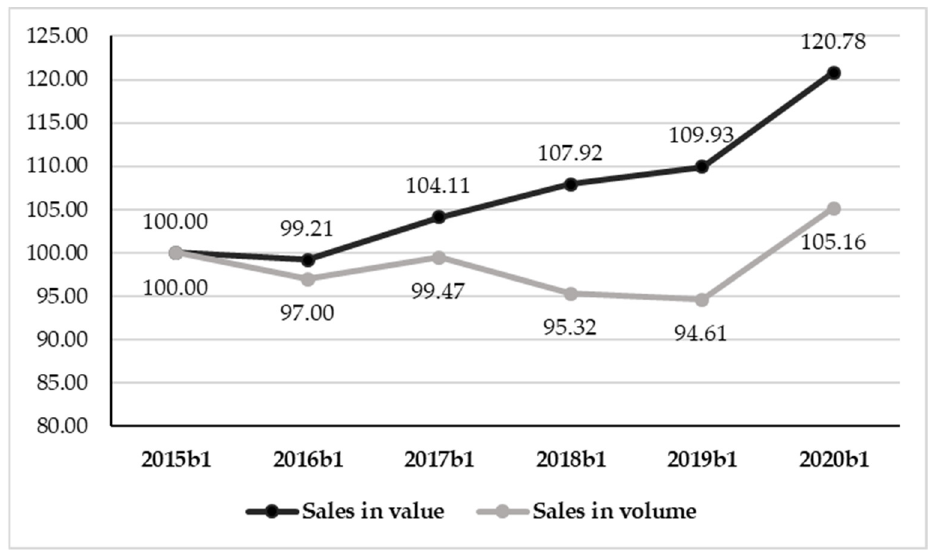
Figure 2. Indexes of wine sales in value and volume in MMR from 2015 to 2020 in b1 (base 100 = 2015b1).